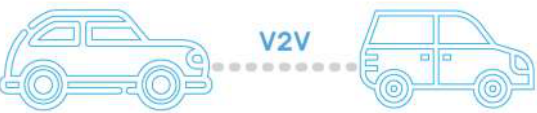
Figure 1. ©V2V communication Copyright 2017, 5GAA